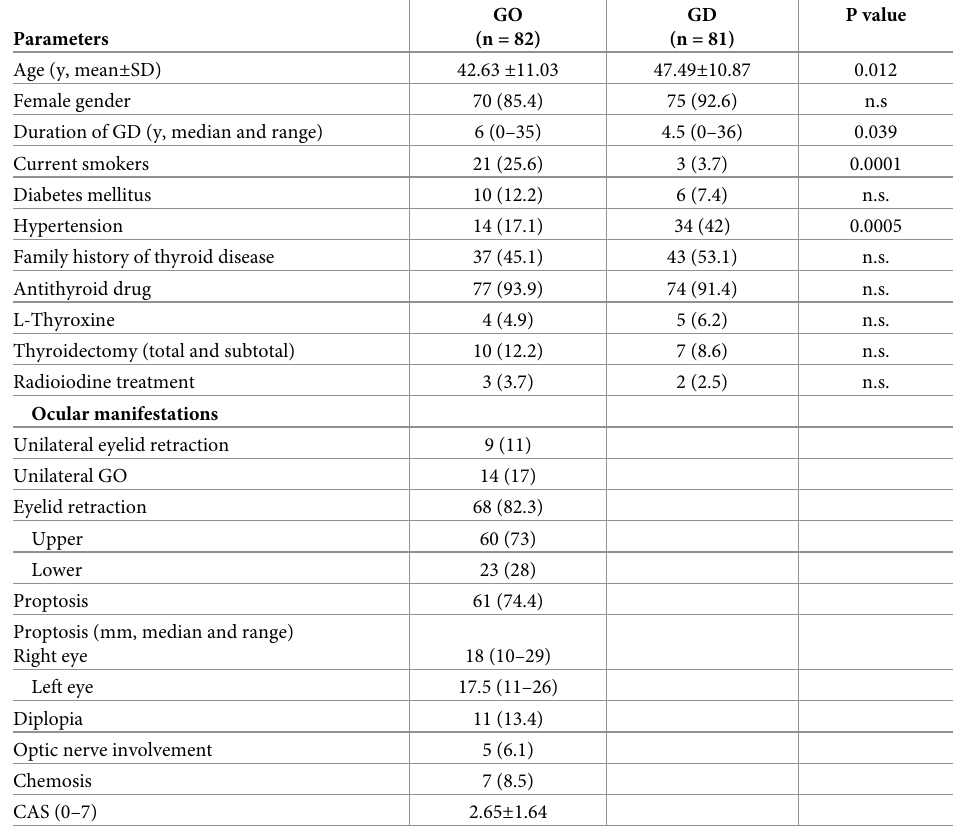
Table 1. Demographic and clinical data of GO